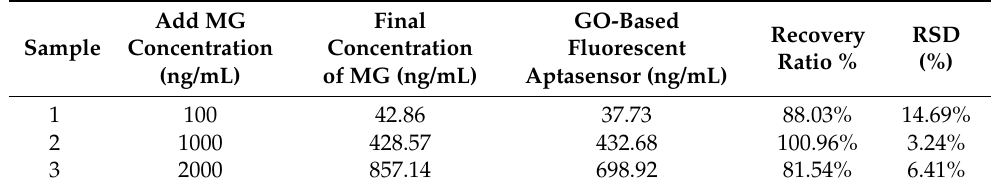
Table 3. Detection of MG in 5-fold diluted actual water from the aquatic product market using aptamer MG-36-17 in GO-based fluorescent